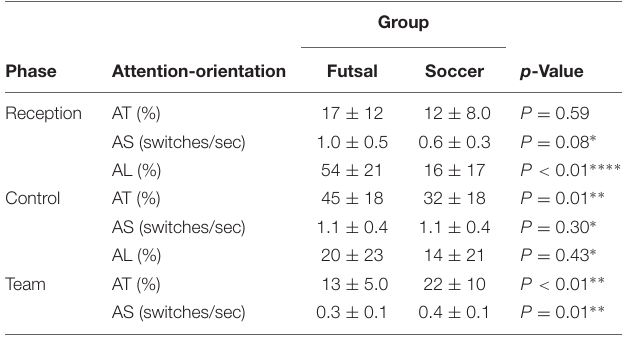
TABLE 2 | Mean relative attention-orientation time on player-directed area (AT, in percentage), attention-orientation switches (AS, in switches/sec) and last-attention orientation on ball-directed area (AL, in percentage) ± SD of the two groups across the three different phases.